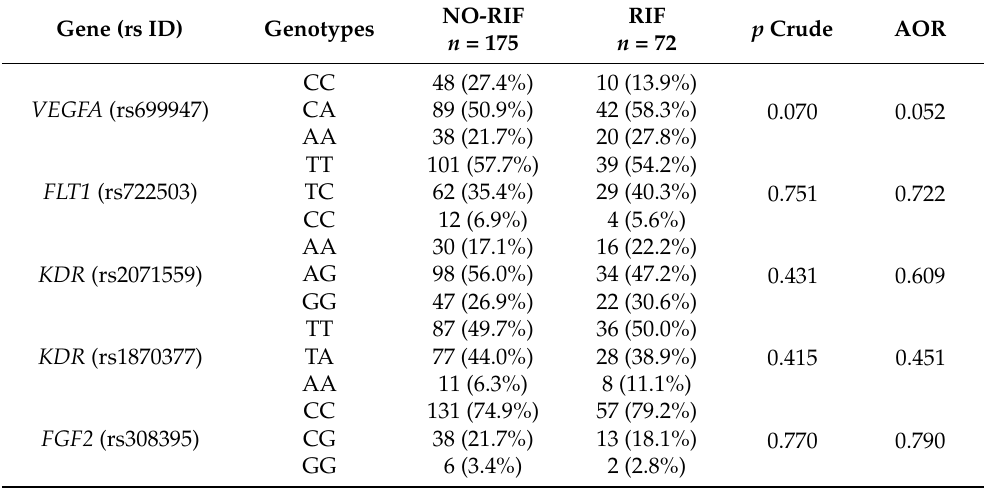
Table 6. Genotypic frequencies of selected polymorphisms between RIF and NO-RIF infertile